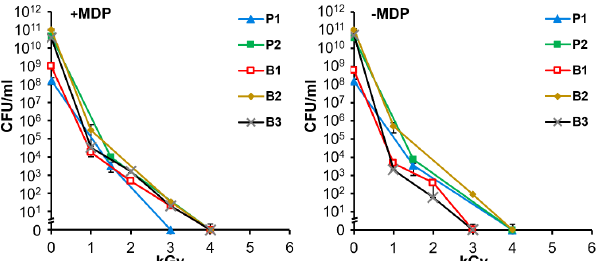
Figure 3. Irradiation inactivation of A. baumannii colony-forming units. A. baumannii samples P1, P2, B1, B2, and B3 were irradiated with or without MDP (as indicated) and analyzed for replicative viability. Serial dilutions of irradiated bacteria were plated to determine CFU/mL.